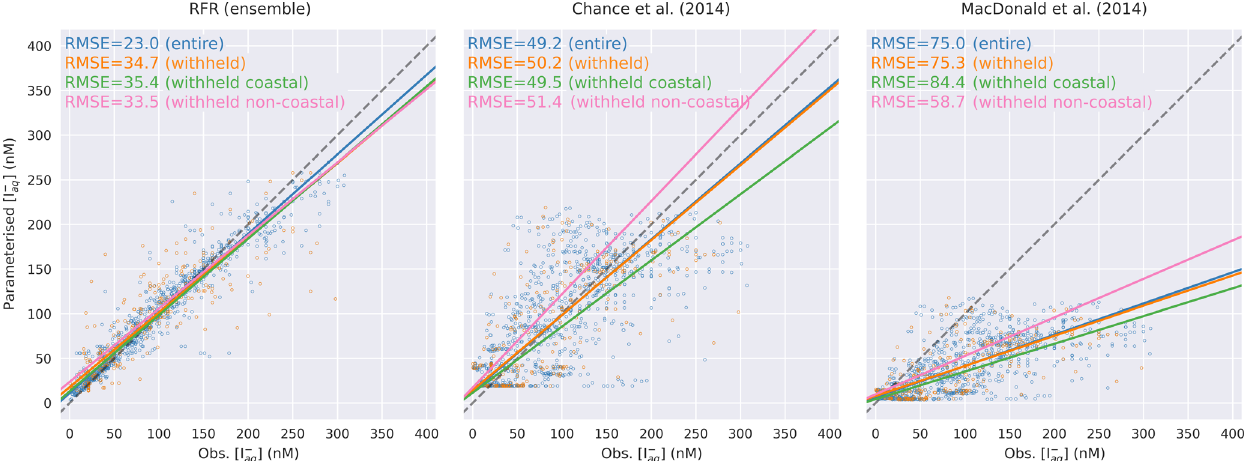
Figure 4. Regression plots showing comparisons between predicted values and observations in the entire (blue, N = 1293) and withheld data (orange, N = 259), withheld data classed as coastal (green, N = 157), and the withheld data classed as non-coastal (pink, N = 102). Solid lines give the orthogonal distance regression line of best fit. The dashed grey line gives the 1 : 1 line. Root mean square error for each line is annotated by subplot in nanomolar (nM). Table 3. Statistics for observations and predictions by the ensemble prediction (RFR(ensemble)) and existing parameterisations against the entire dataset of observations. The root mean square error is shown against the entire and the withheld data. Mean SD 25%